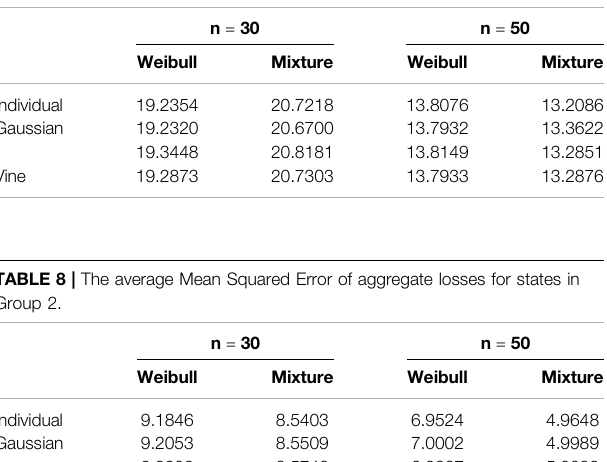
TABLE 7 | The average Mean Squared Error of aggregate losses for states in Group 1.